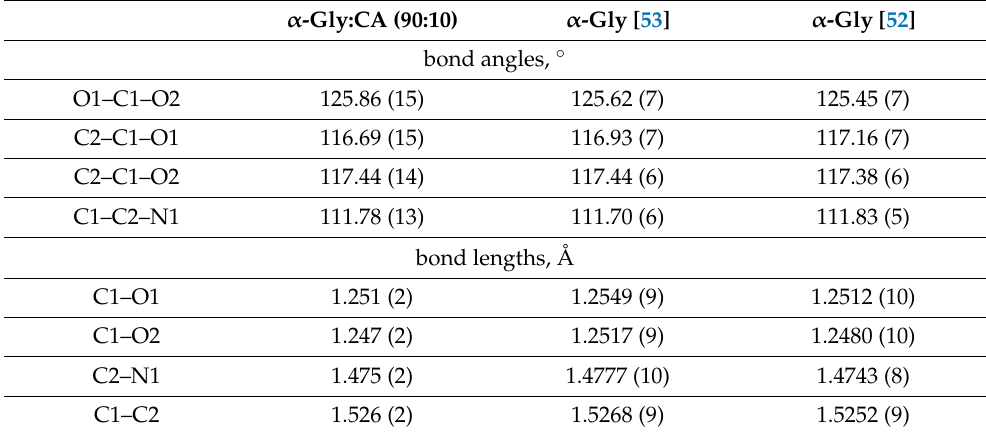
Table 4. Bond angles and bond lengths C1–O1, C1–O2, C2–N1, and C1–C2 of glycine molecules in CA-doped and nominally pure α -Gly crystals [52,53].